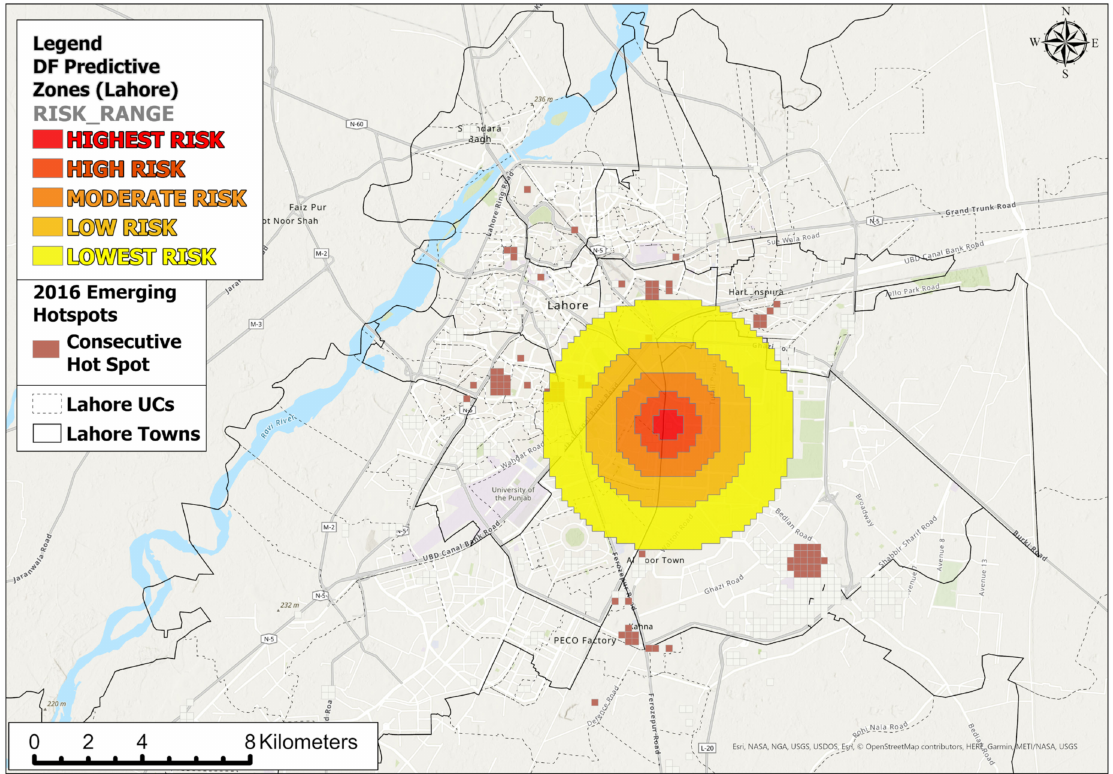
Figure 10. DF prediction zones based on repeat and near-repeat incidents that follow a spatiotemporal influential range of previous DF